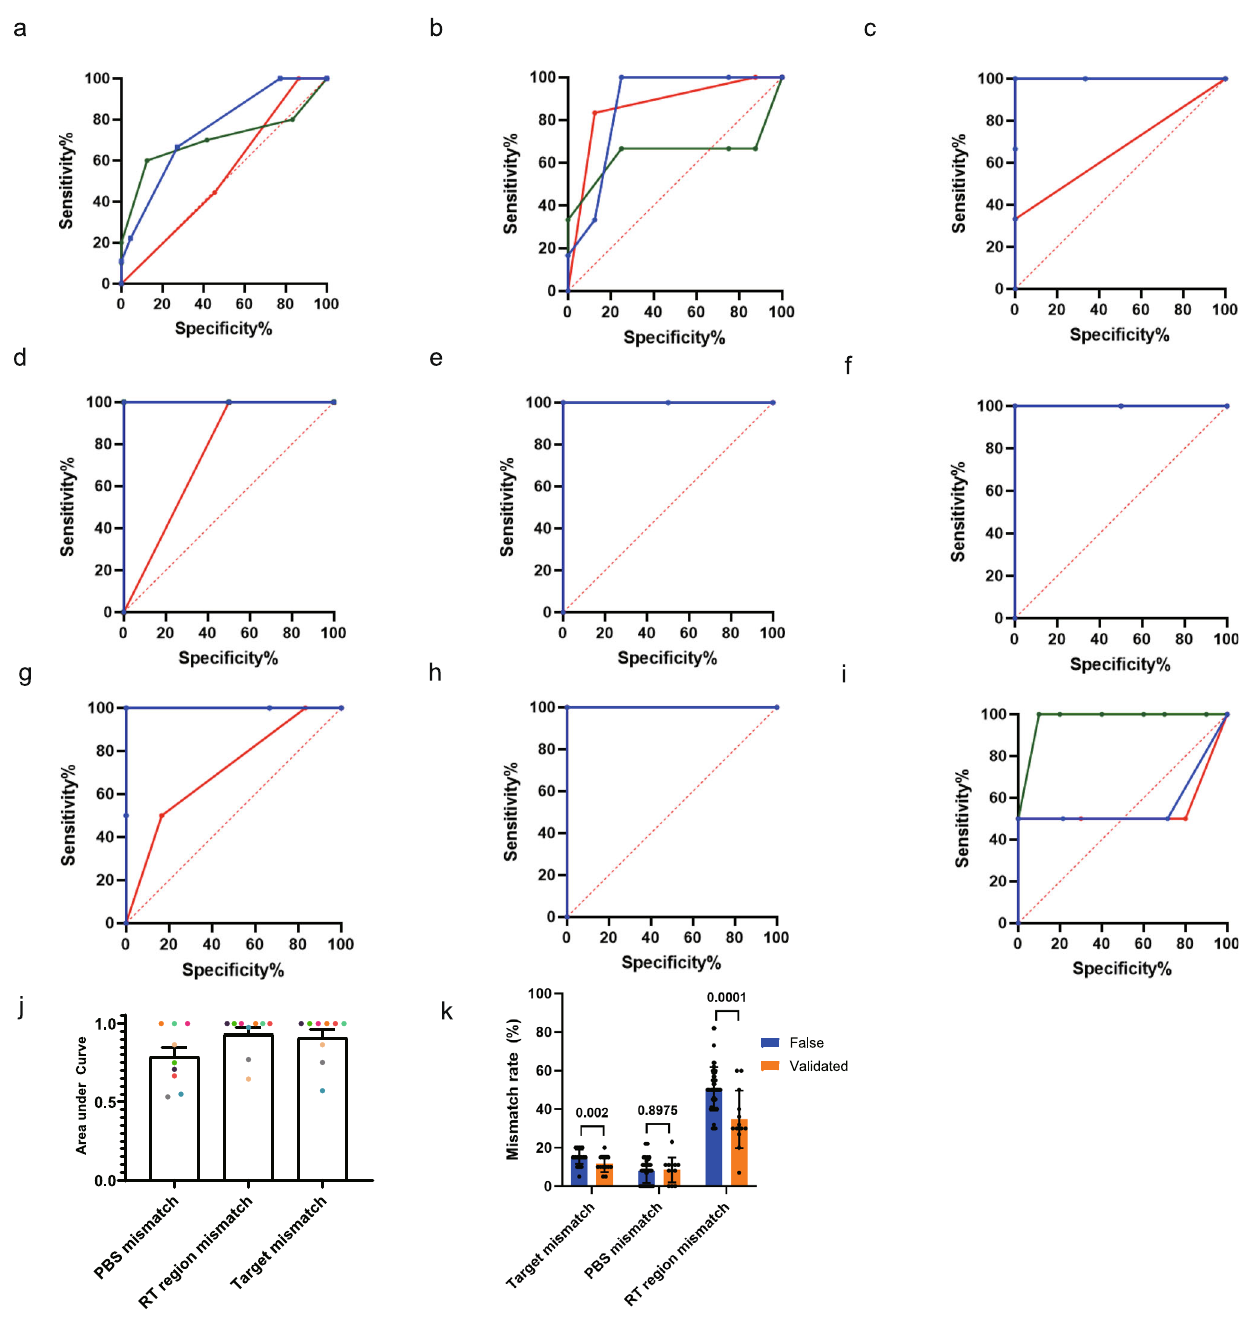
Fig. 7 | Mismatch analysis by region. a – i ROC curves for mismatches in the PBS (red), RT template (green), and target (blue) regions for the a HEK4 (+2G to T), b HEK4 (+3 TAA ins), c HBB (+4A to T), d HEK3 (+1 CTT ins), e FANCF (+6G to C), f EMX1 (+5GtoT), g DNMT1 (+6GtoC), h RUNX1 (+6GtoC),and i VEGFA (+5GtoT) pegRNAs. j Area under the ROC curve for the nine different pegRNAs ( n =10 independent experiments each represented by different color). k Mismatch rates for sites predicted by TAPE-seq, false positive sites ( n =54 independent target loci